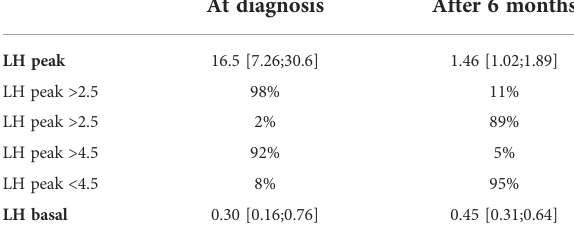
TABLE 4 Evaluation of HPG axis suppression by GnRH stimulation test.